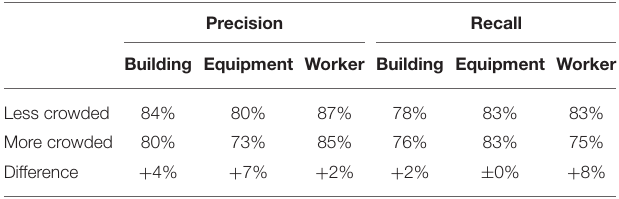
TABLE 1 | Performance of the best model in detecting large and small objects. Precision Recall